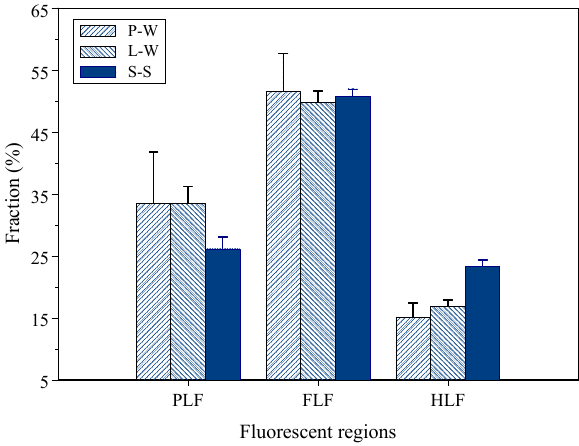
Figure 3. The PLF, FLF and HLF percentages for P-W, L-W and S-S.